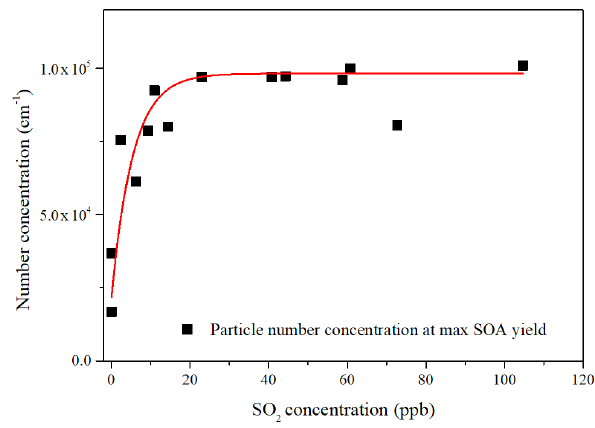
Figure 1. Particle number concentrations of SOA in the photooxi- dation of the cyclohexene / NO x / SO 2 system with different initial SO 2